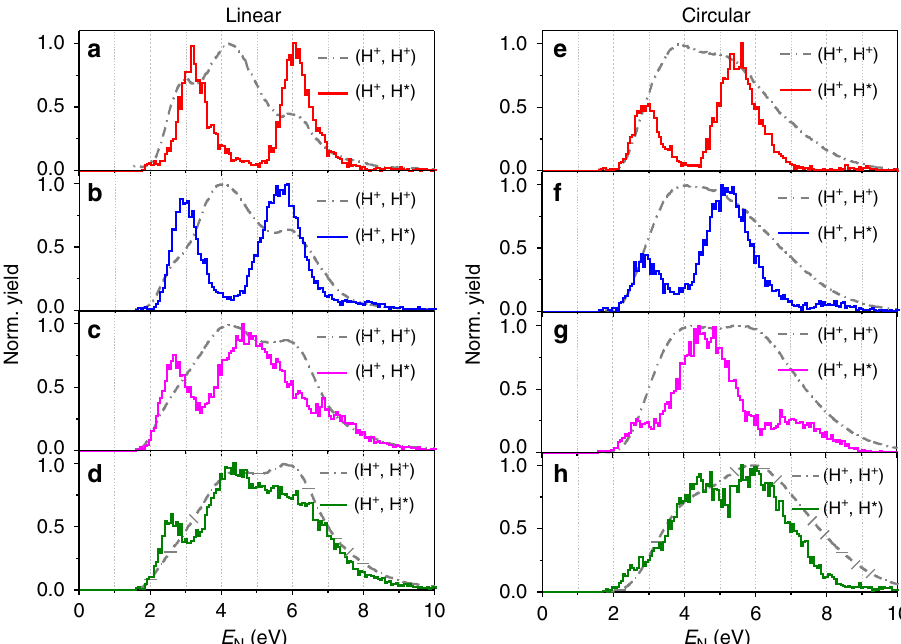
Fig. 3 Laser intensity-dependent nuclear kinetic energy spectra. Measured E N spectra of the (H + , H + ) (gray dash-dotted curves) and (H + , H * ) (colored solid curves) channels driven by ( a ) – ( d ) linearly and ( e ) – ( h ) circularly polarized UV pulses. The laser intensities of the UV pulse and the corresponding Keldysh parameter are ( a ) 0.6 × 10 14 W/cm 2 ( γ ~2.97), ( b ) 1.0 × 10 14 W/cm 2 ( γ ~2.3), ( c ) 1.75 × 10 14 W/cm 2 ( γ ~1.74), ( d ) 2.7 × 10 14 W/cm 2 ( γ ~1.4), ( e ) 1.3 × 10 14 W/cm 2 ( γ ~2.02), ( f ) 1.87 × 10 14 W/cm 2 ( γ ~1.68), ( g ) 2.44 × 10 14 W/cm 2 ( γ ~1.47), ( h ) 2.8 × 10 14 W/cm 2 ( γ ~1.37),